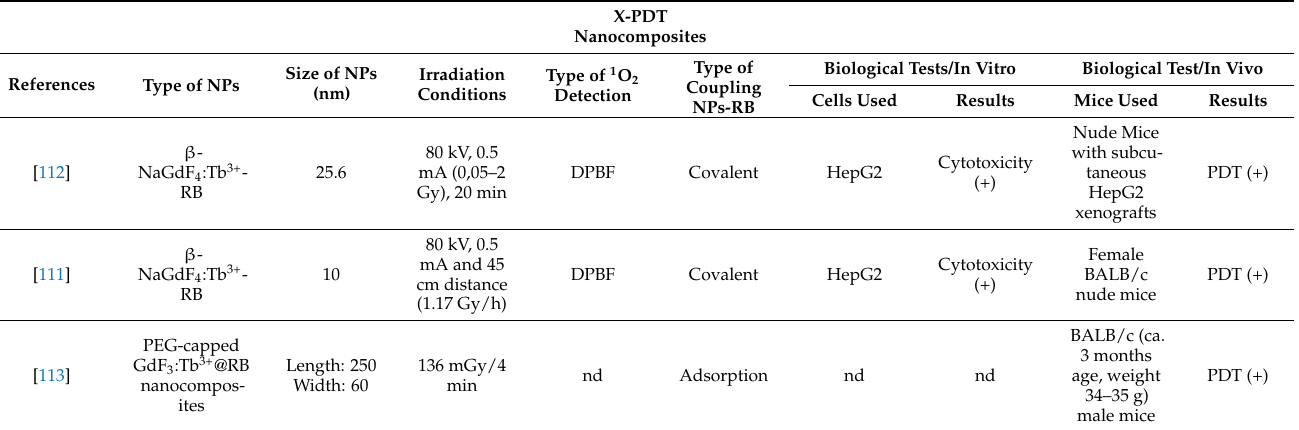
Table 9. References dealing with nanocomposites@RB under X-ray, including the type of NPs, along with their size, excitation wavelength, type of detection of 1 O 2 , type of coupling between the NPs and the RB, and the types of biological tests